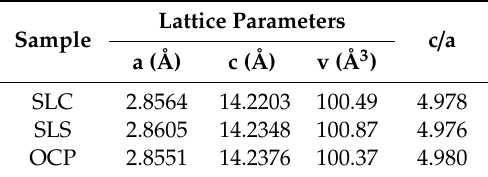
Figure 1. XRD patterns of LL-811 samples prepared by different methods. Table 1. Lattice parameters of LL-811 samples prepared by different methods.